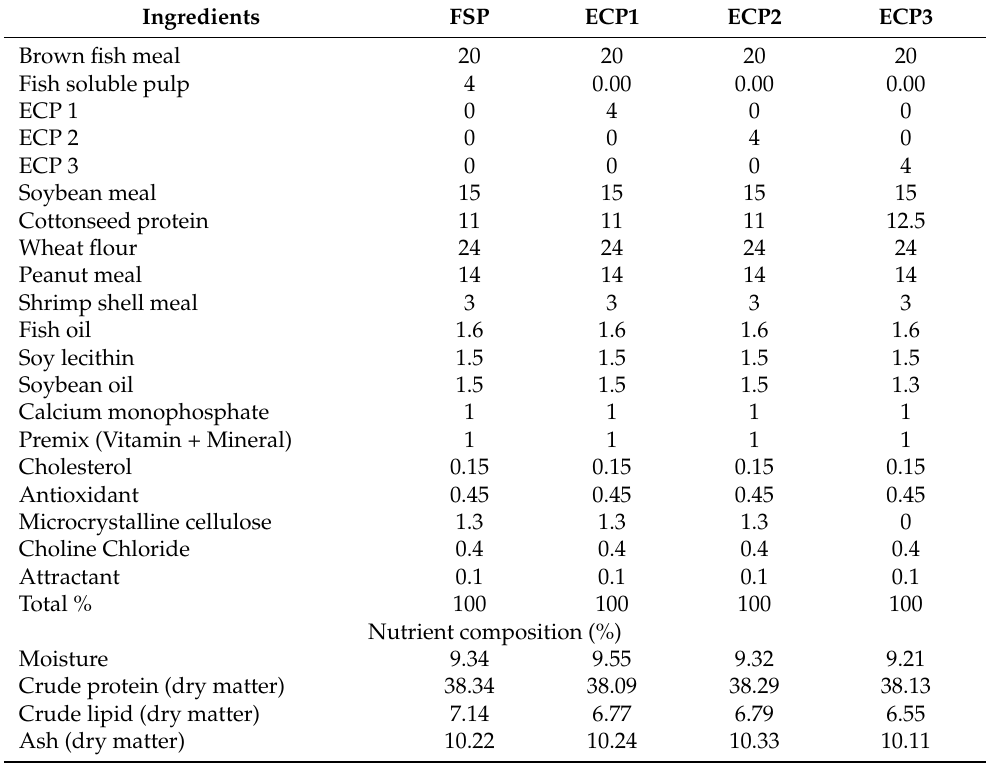
Table 1. Formulation and proximate composition of the experimental diets (% dry matter).